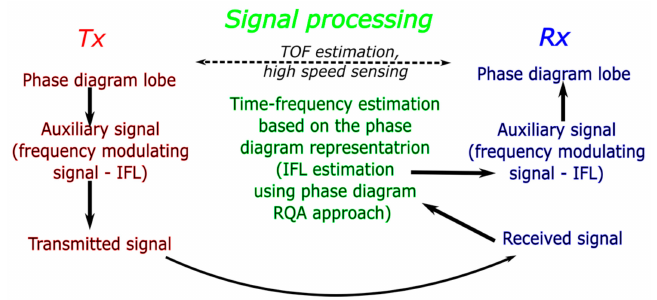
Figure 1. Paper organization: the transmission part ( Tx ) is presented in Section 3, the signal processing part based on the phase diagram properties is presented in Section 4 and the reception part ( Rx ) which includes the applications is presented in Section